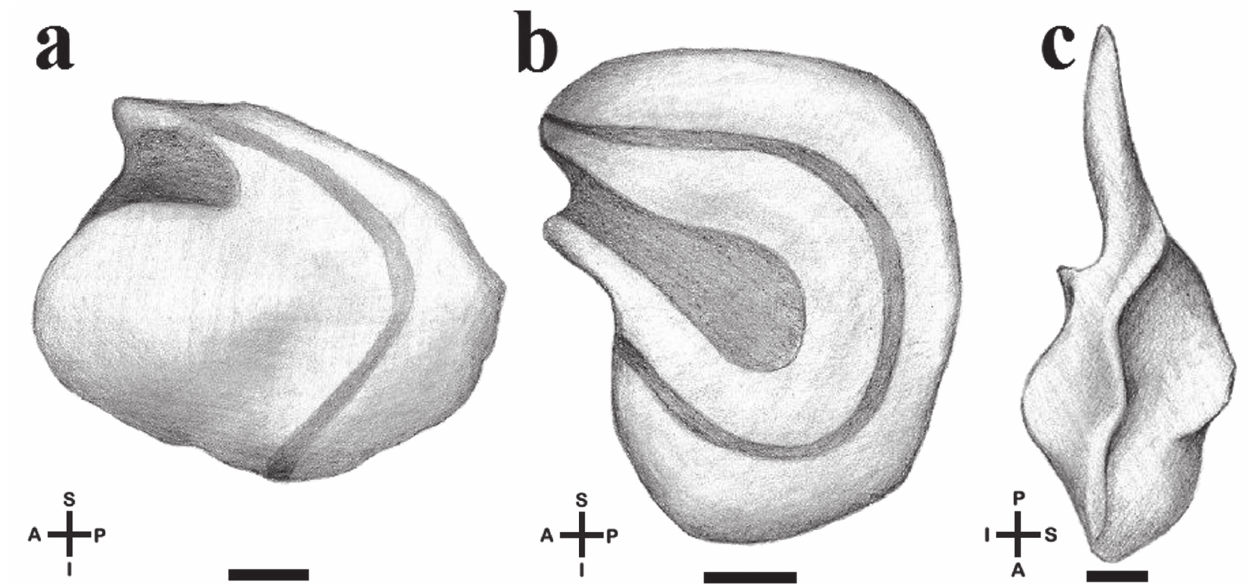
Fig. 13. Right serie of otoliths of Ancistrus sp. (a) Lapillus, Scale bar = 200 µm; (b) Asteriscus, Scale bar = 200 µm; (c) Sagitta, Scale bar = 200